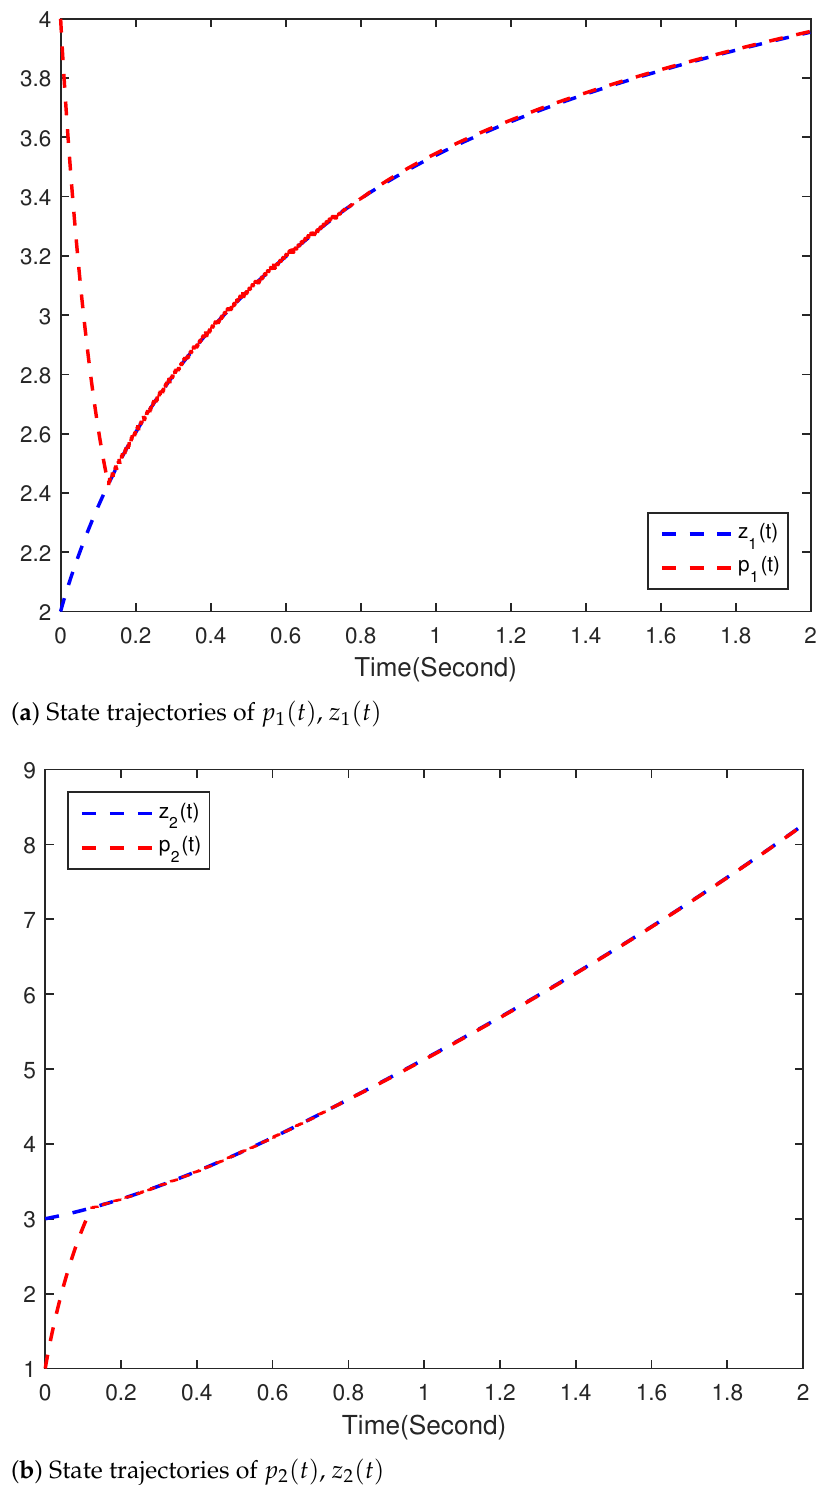
Figure 2. Time responses of p ( t ) and z ( t )